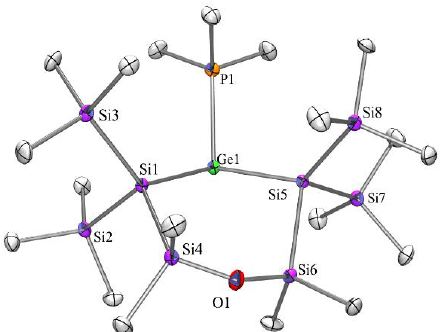
Figure 5. Molecular structure of compound 9 (thermal ellipsoid plot drawn at the 30% probability level). All hydrogen atoms are omitted for clarity (bond lengths in Å , angles in deg).